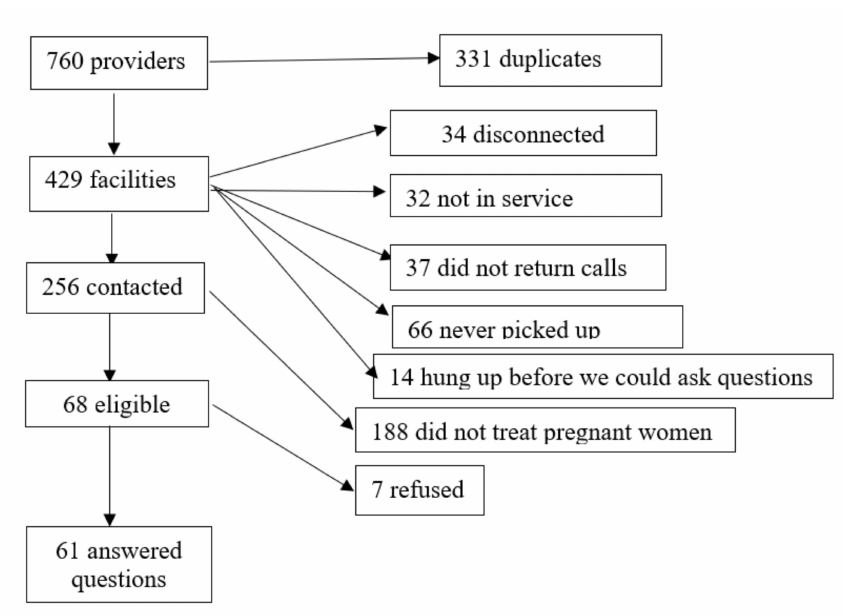
Figure 1. Results of phone calls to health